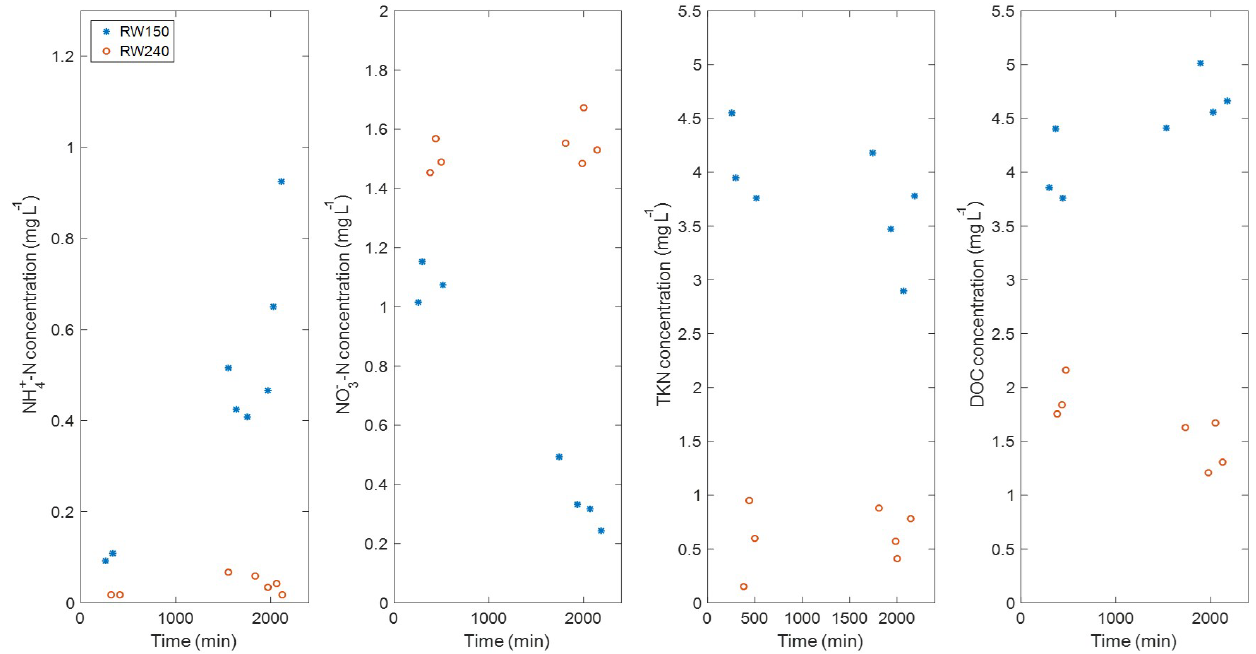
Figure 4. Outflow concentrations of NH + RW150 and RW240